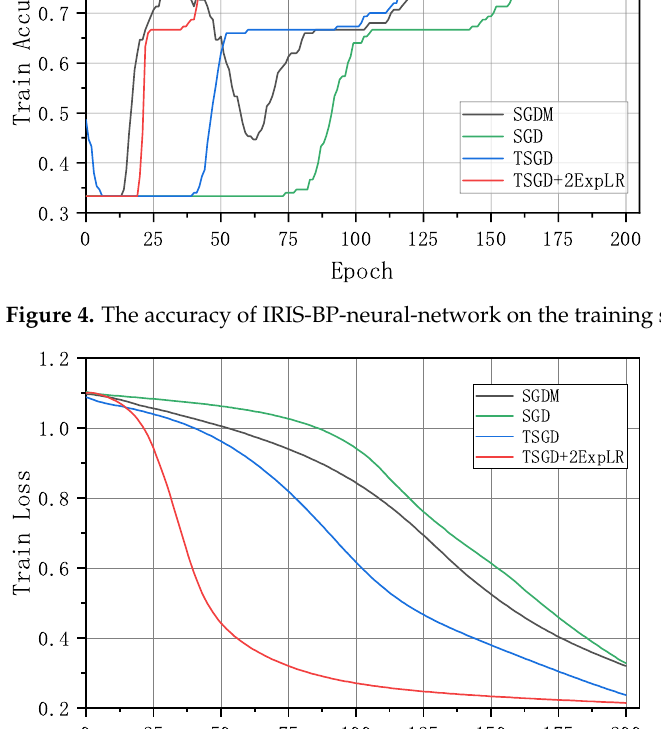
lr = 0.1, lr u = 0.5, lr l = 0.005, then T = ceil(samplesize/batchsize) * epoch = 25,000, and thus ( log ( ρ T ,10 ) / T ) ≈ ρ = 10 0.999815. This is also applicable to ρ 1 = ρ 2 = 0.999696. The